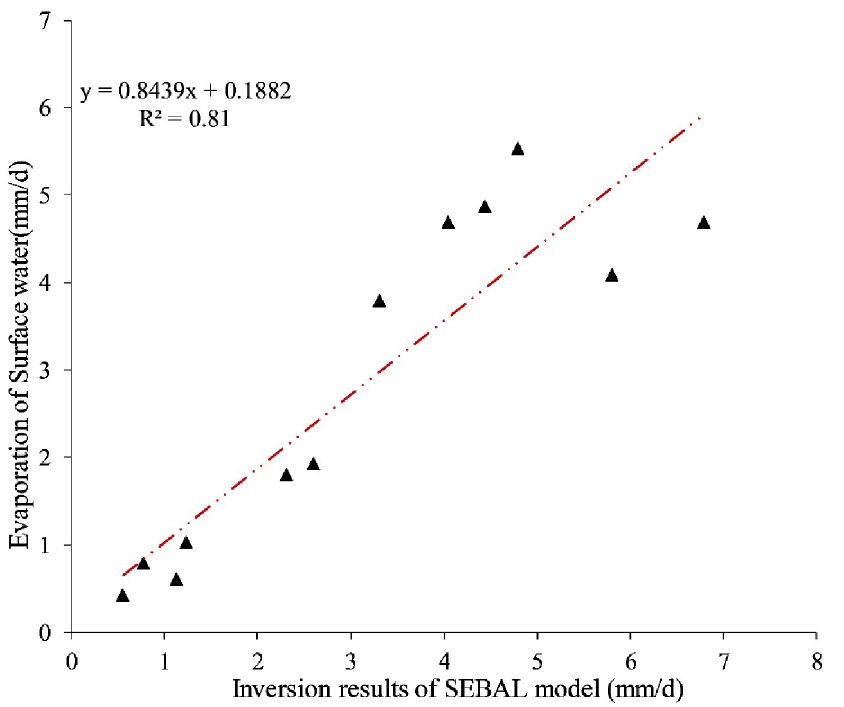
Fig 2. Validation scatter plot of the SEBAL model inversion results and meteorological data.